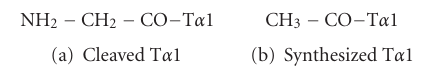
Figure 9: Di ff erences in the structures of the synthesized T α 1 and the cleaved T α